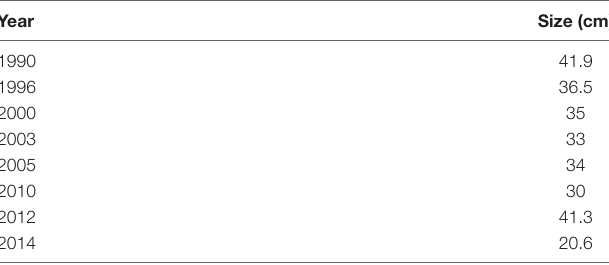
TABLE 7 | Mean length of turbot (cm) caught by trawl surveys in the Black